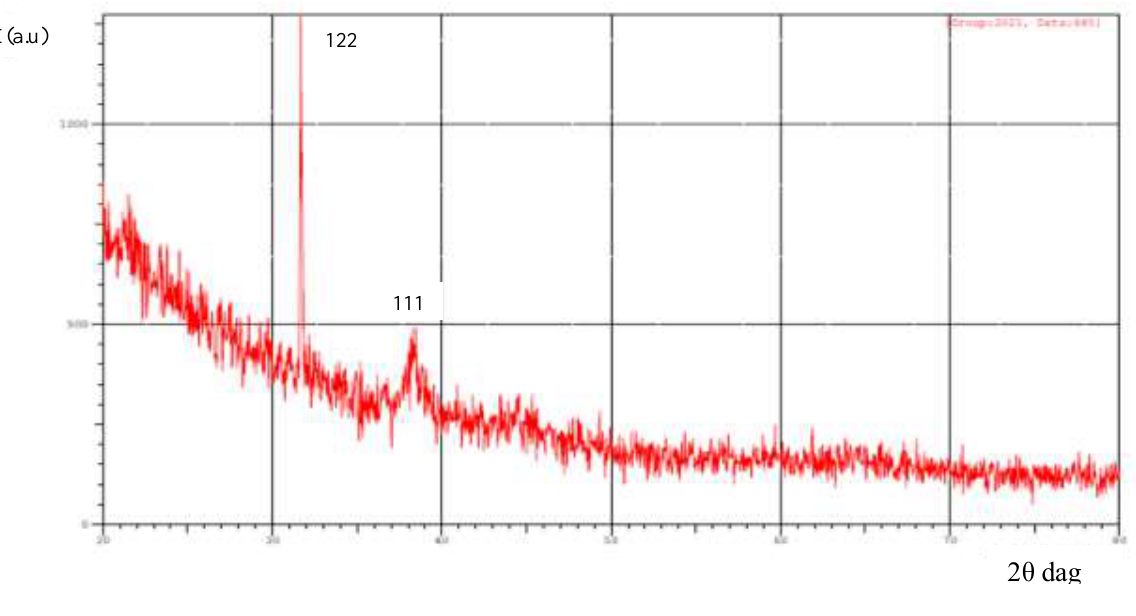
Figure 4: XRD diagram of silver nanoparticles.